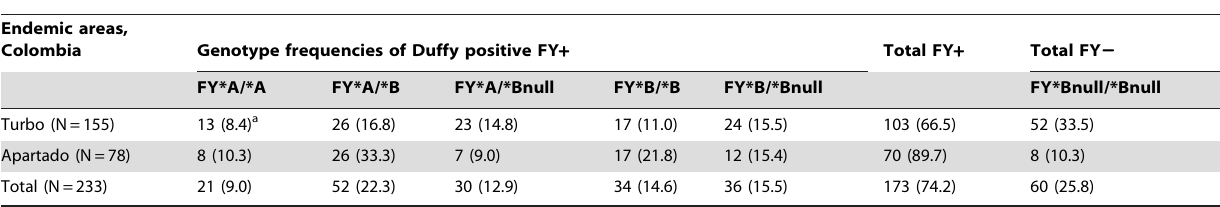
Table 1. Frequencies of genotypes for Duffy antigen receptor for chemokines (DARC) under the study. Endemic areas, Colombia Genotype frequencies of Duffy positive FY +